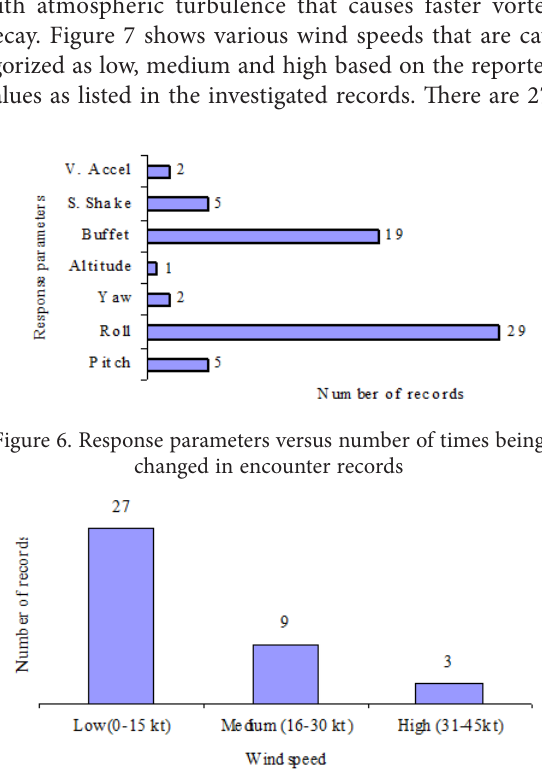
Figure 7. Records distribution according to reported wind